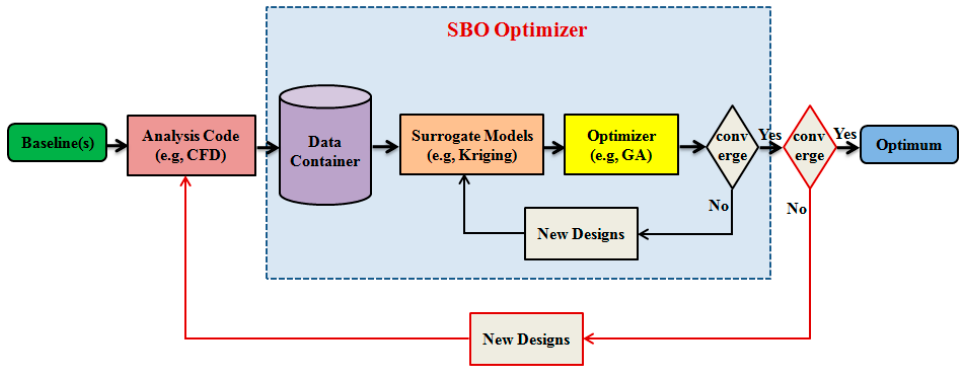
Figure 5. Schematic drawing of surrogated based optimization.